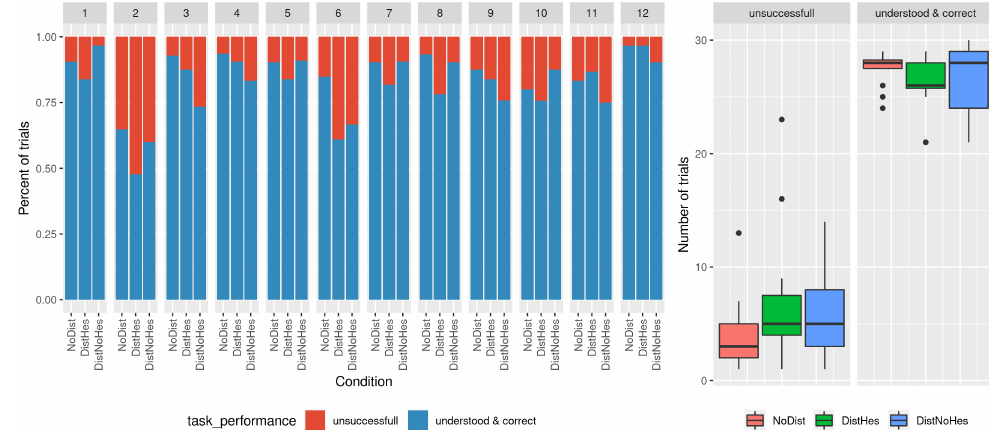
Figure 7. Understanding (problems) for each participant ( left ) and over all participants ( right ).